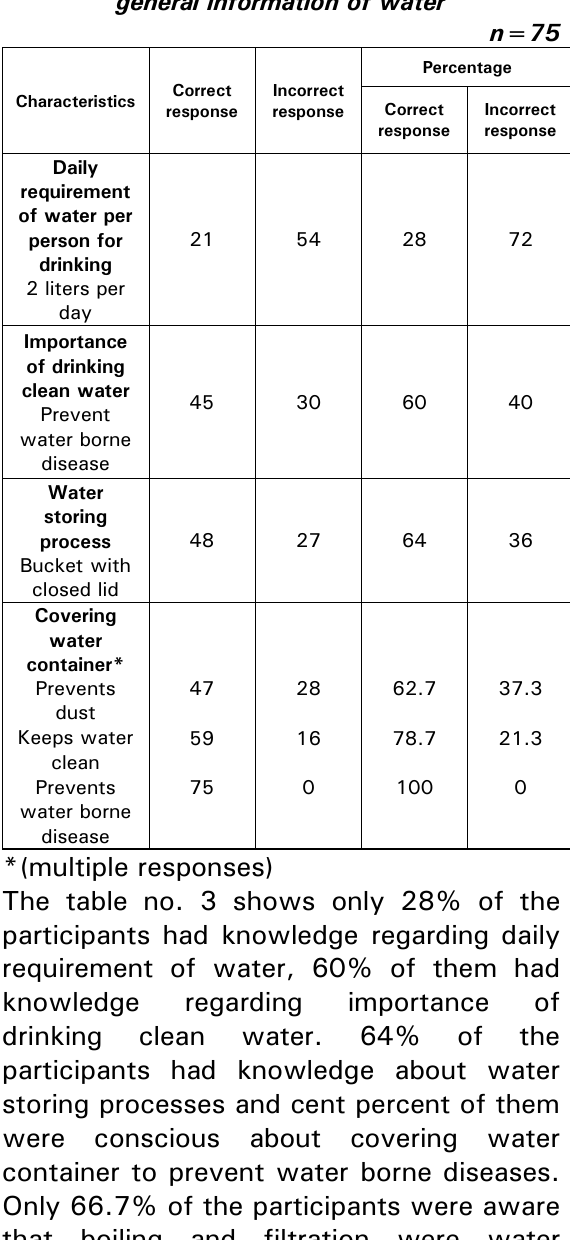
Table 3: Respondent’s knowledge